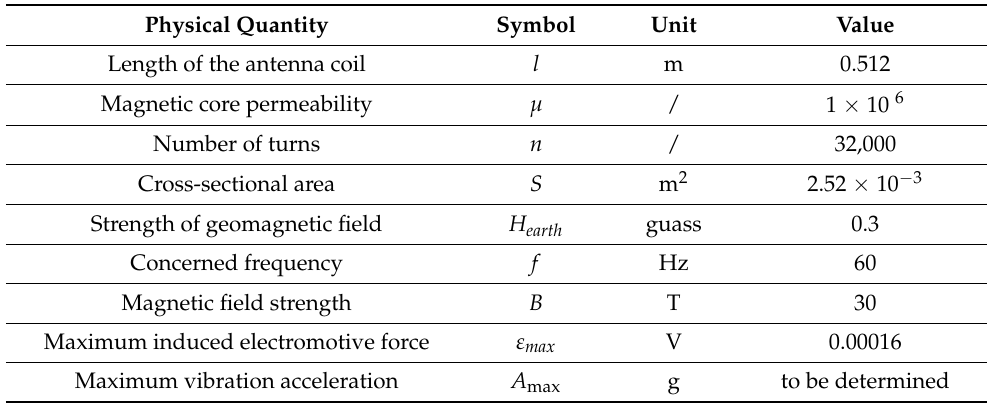
Figure 1. Schematic diagram of magnetic antenna structure in the magnetic field. Table 1. The parameters of the antenna.